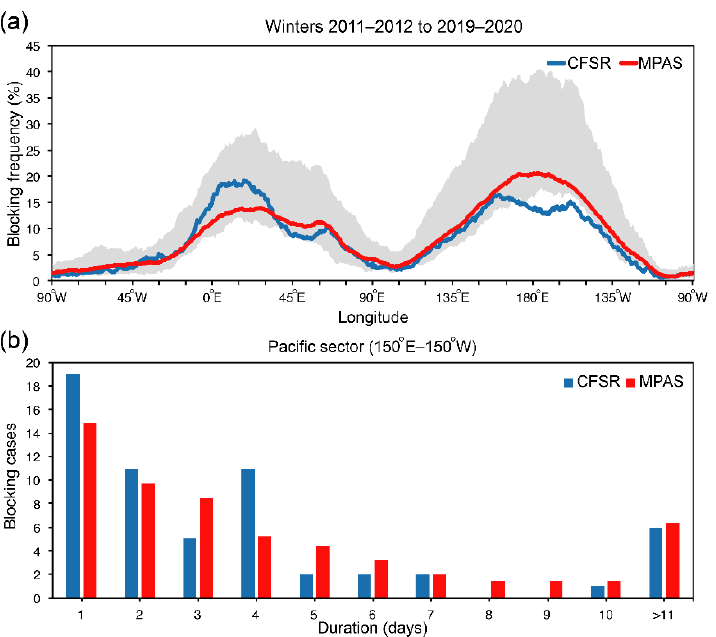
Figure 11. ( a ) Percentage frequency of blocking as a function of longitude for CFSR (blue) and MPAS simulations average (red). The shading area is defined by the minimum and maximum values of the ensemble members. ( b ) Histograms of the averaged blocking cases as a function of durations for the Pacific sector (150 – 210° E).